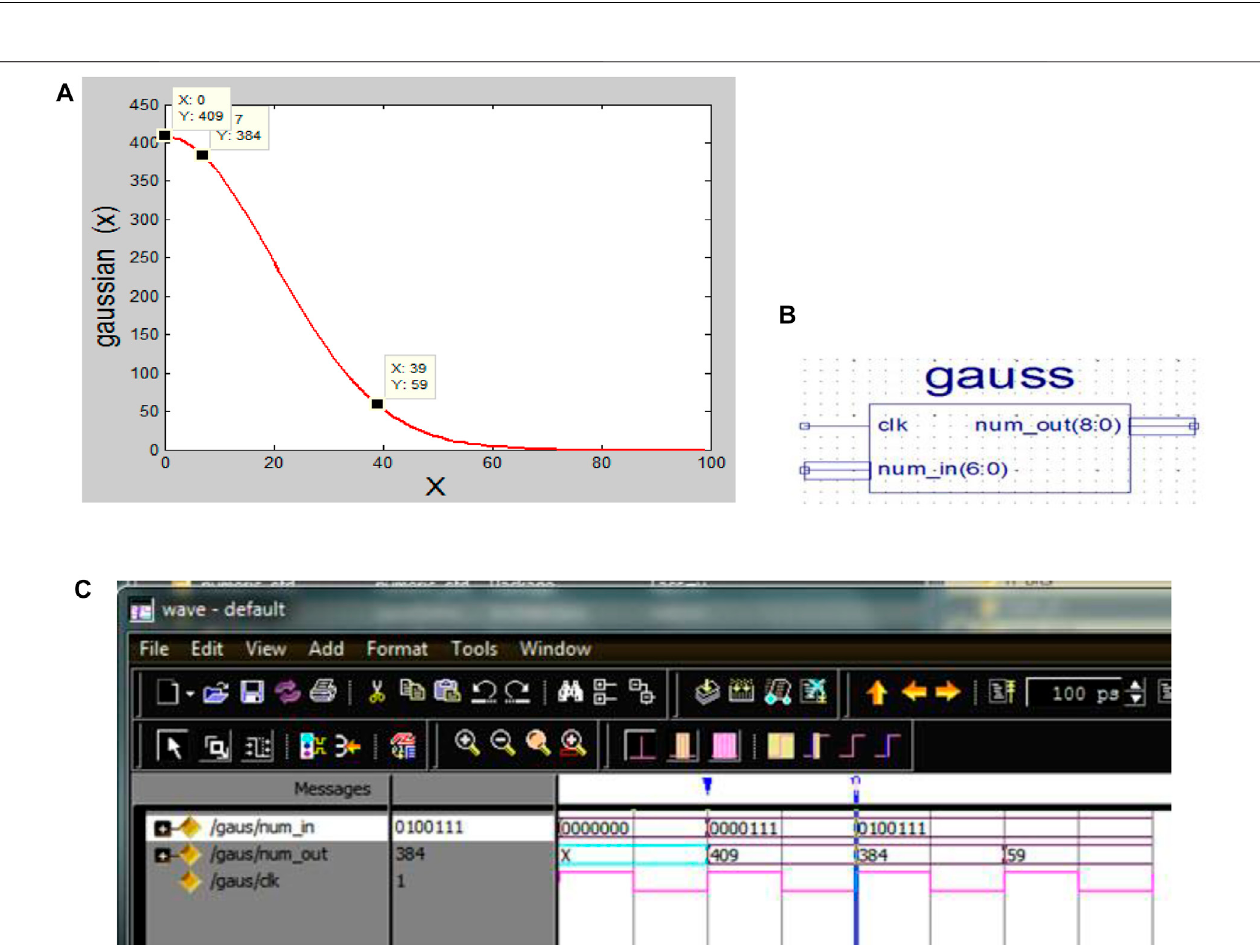
Frontiers in Energy Research |